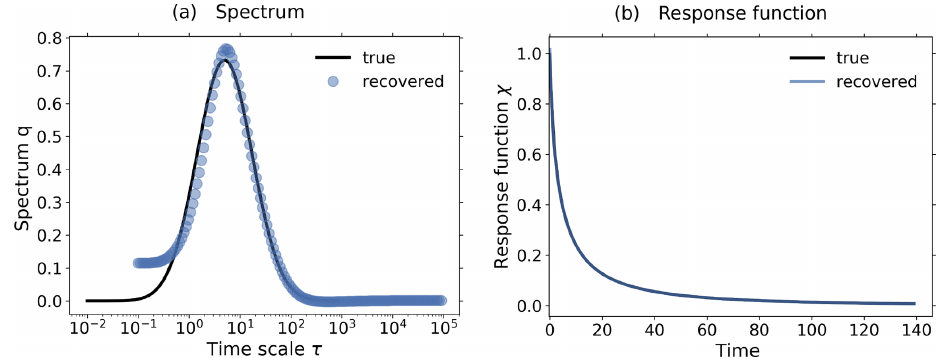
Figure E5. Response function χ(t) and spectrum q λ recovered from toy model data taking the RFI parameters M = 140, log τ min = − 1, and log τ max = 5. Blue dots in (a) and blue line in (b) indicate the recovered values for the spectrum and for the response function, while black lines indicate their “true”